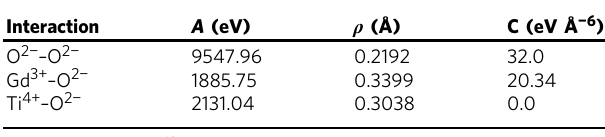
Table 2 Parameterization of the Buckingham potential used in this